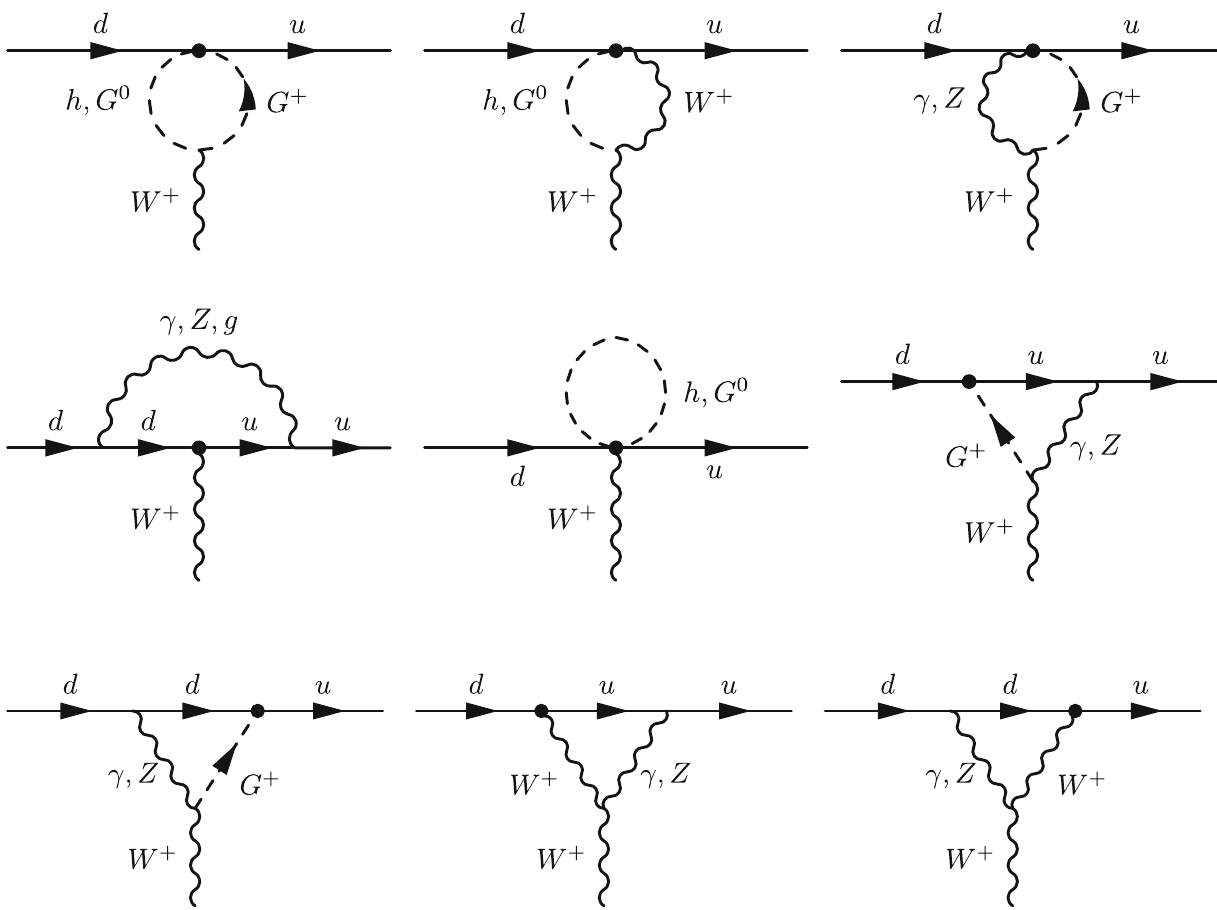
Fig. 16 1PI diagrams contributing to the udW + 4-point function which were used to calculate the self-renormalization of O Hud